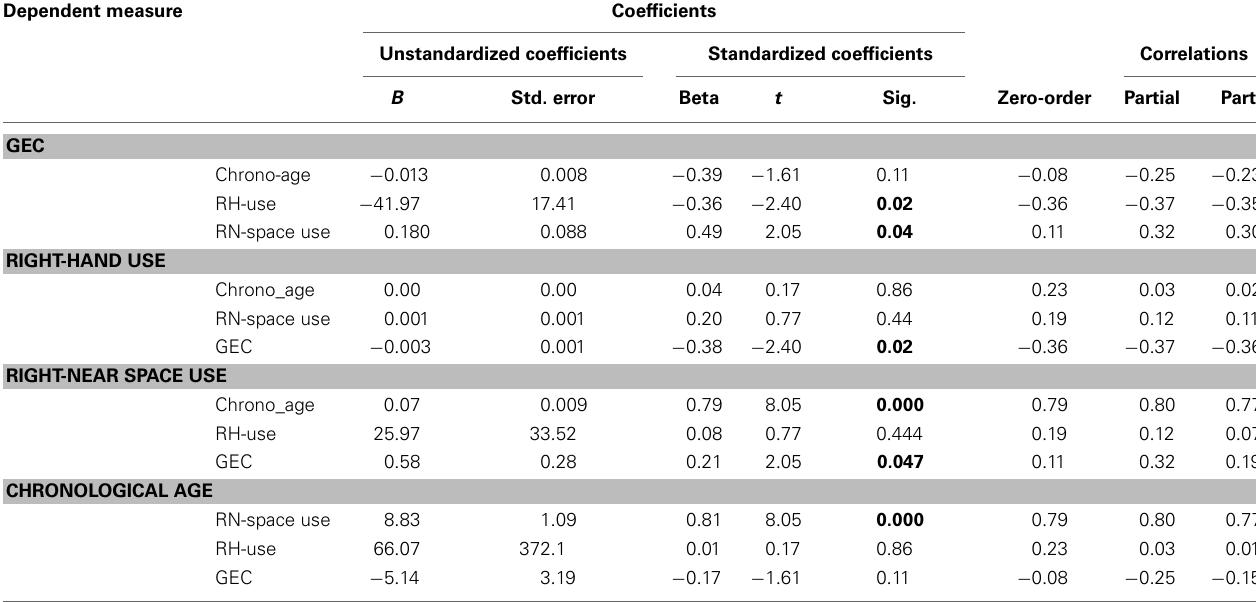
Table 2 | Results of the regression analyses. Note the relationship between hand and space use during the grasping tasks and EF. Dependent